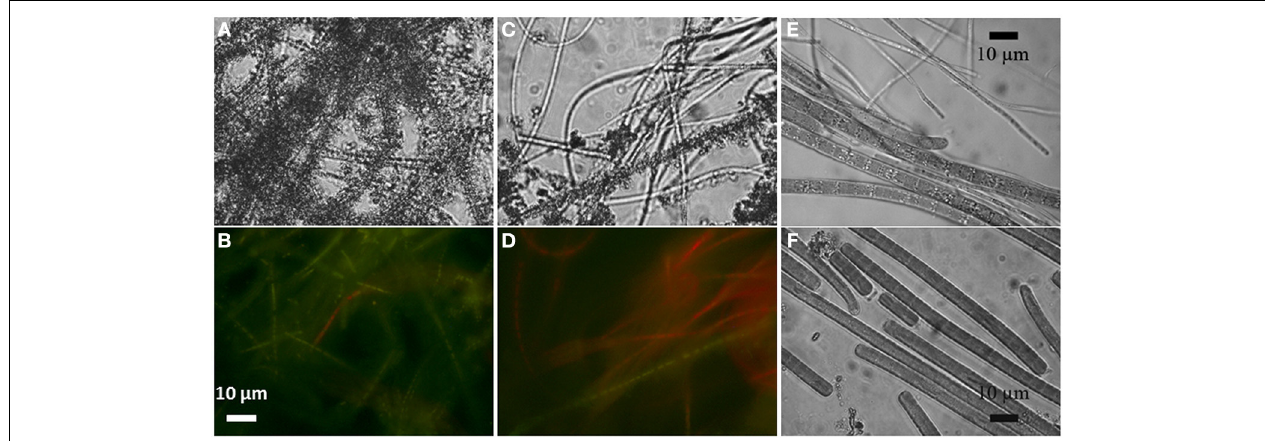
dissolved (C) and the natural red autofluorescence induced by green light resumed (D) . Filaments from the aerated (E) and non-aerated (F) Fe 2 + -rich reactors were not found